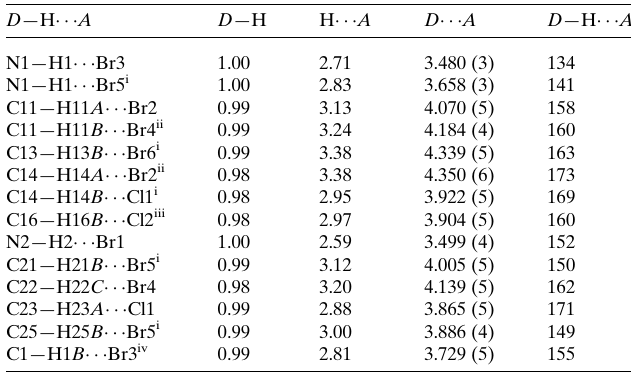
Table 2 Hydrogen-bond geometry (A˚ , (cid:3) ).